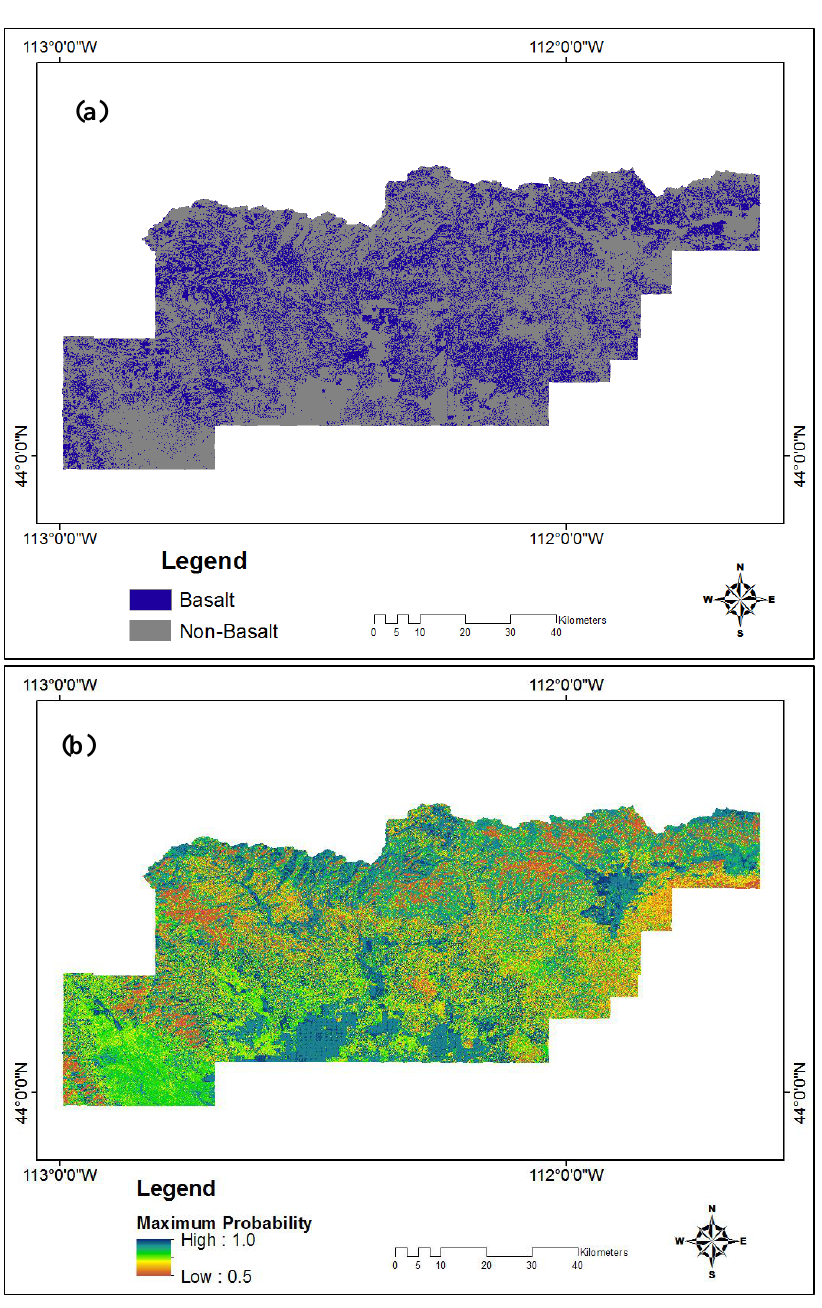
Figure 5. ( a ) Basalt mapping results obtained from the multitemporal Landsat scene using the Random Forest (RF) method, in Clark County, ID, USA. The overall classification rate is 72.35%. ( b ) A classification uncertainty map was also generated by computing the maximum of the probability of class membership between basalt and non-basalt classes. A high probability value equates to low